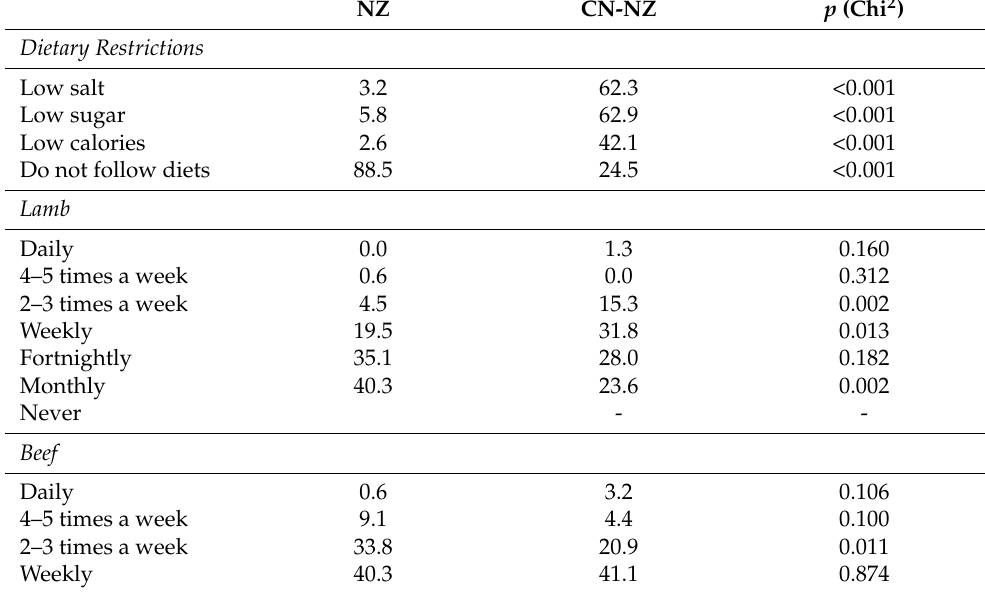
Table 2. Dietary restrictions and consumption frequency of animal protein sources (%) ( p value determined using a Chi-squared test for